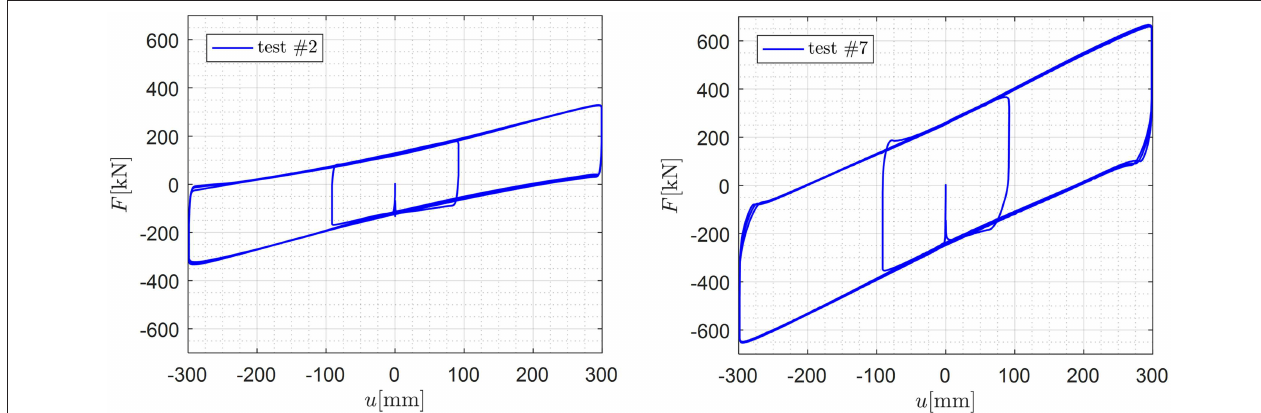
FIGURE 8 | Temperature measurements of the eight thermocouples for test #2 (Top) and test #7 (Bottom) .